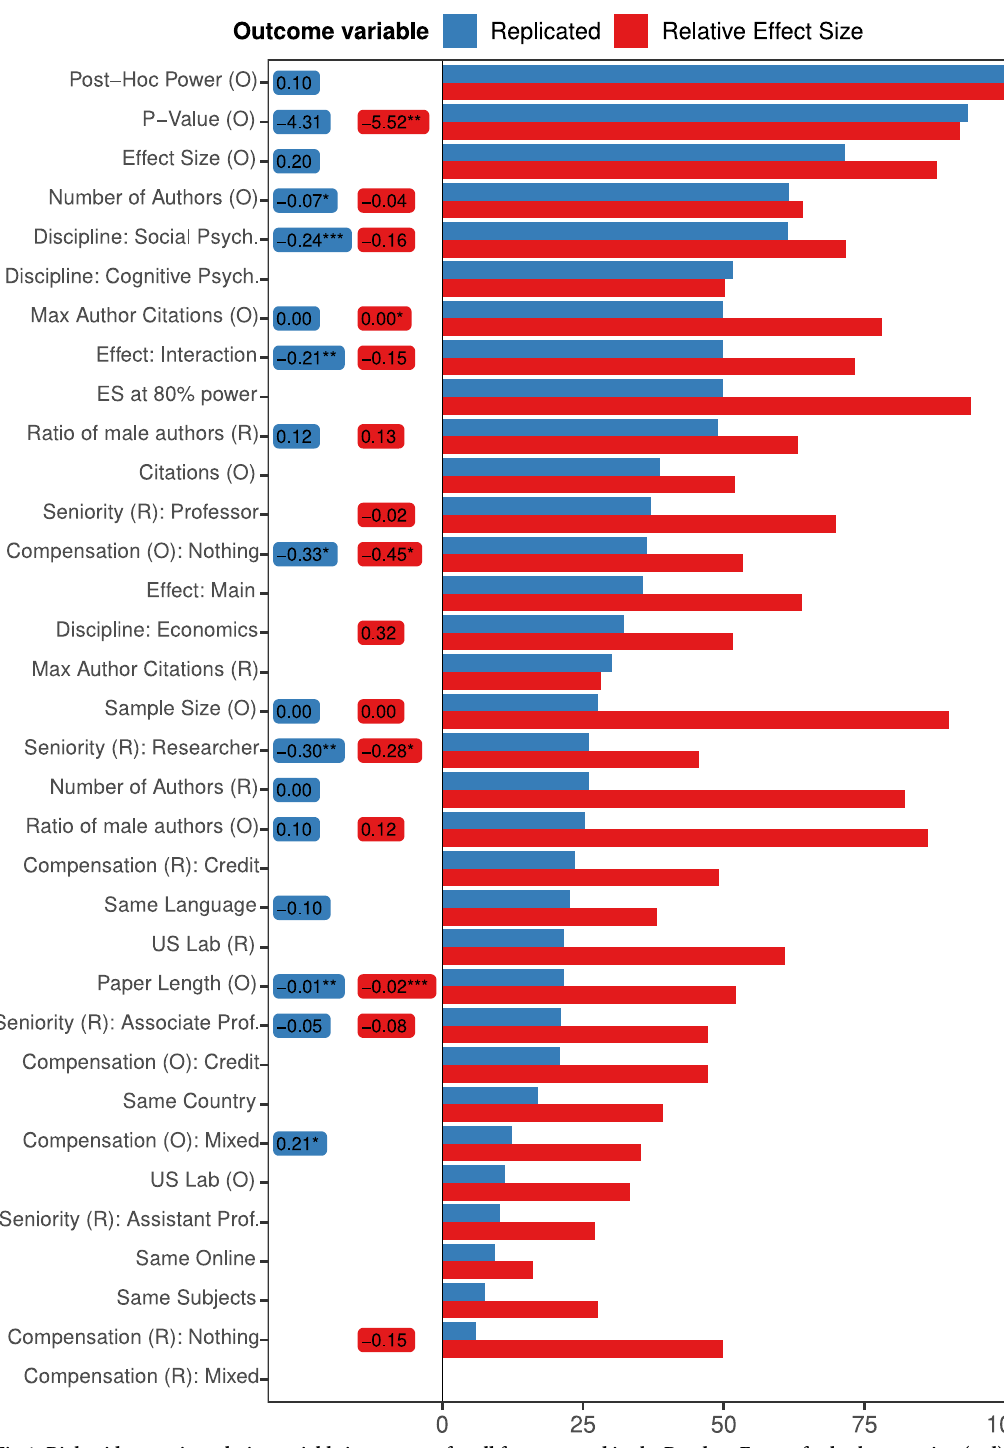
Fig 4. Right side contains relative variable importance for all features used in the Random Forest, for both regression (red) and classification (blue) models, sorted by decreasing contribution to the predictive power of the binary classifier. To the left are average marginal effects for those variables selected by a LASSO and then re-fit in a linear model (Logit for binary, OLS for continuous). Predictably, most of the top variables are statistical properties related to replicability and publication, but also other variables seem to be informative, especially for the Random Forest. For example, whether or not the effect tested is an